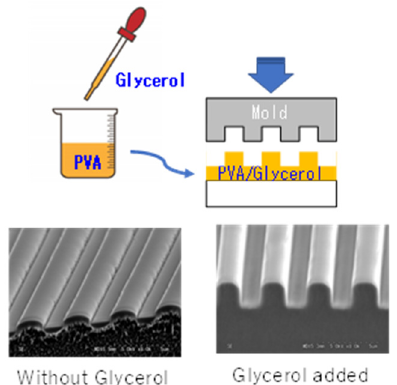
Figure 1. Direct nanoimprint results with and without glycerol additives to PVA (10 MPa, 130 °C, Line width = 2.0 μ m).